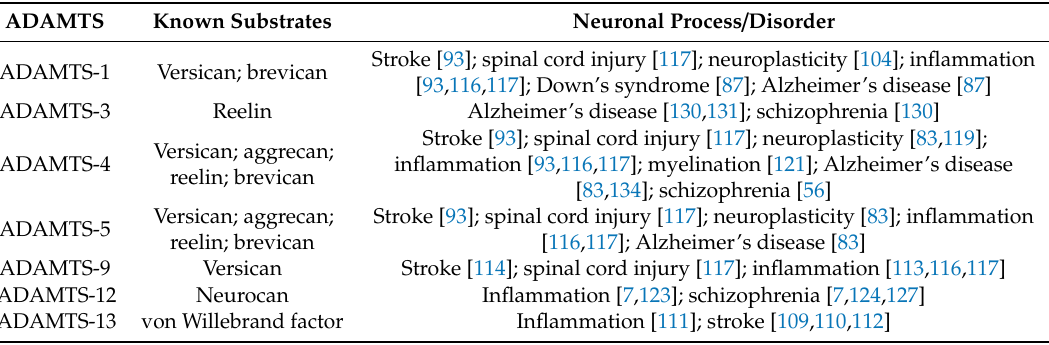
Table 1. ADAMTSs in the central nervous system